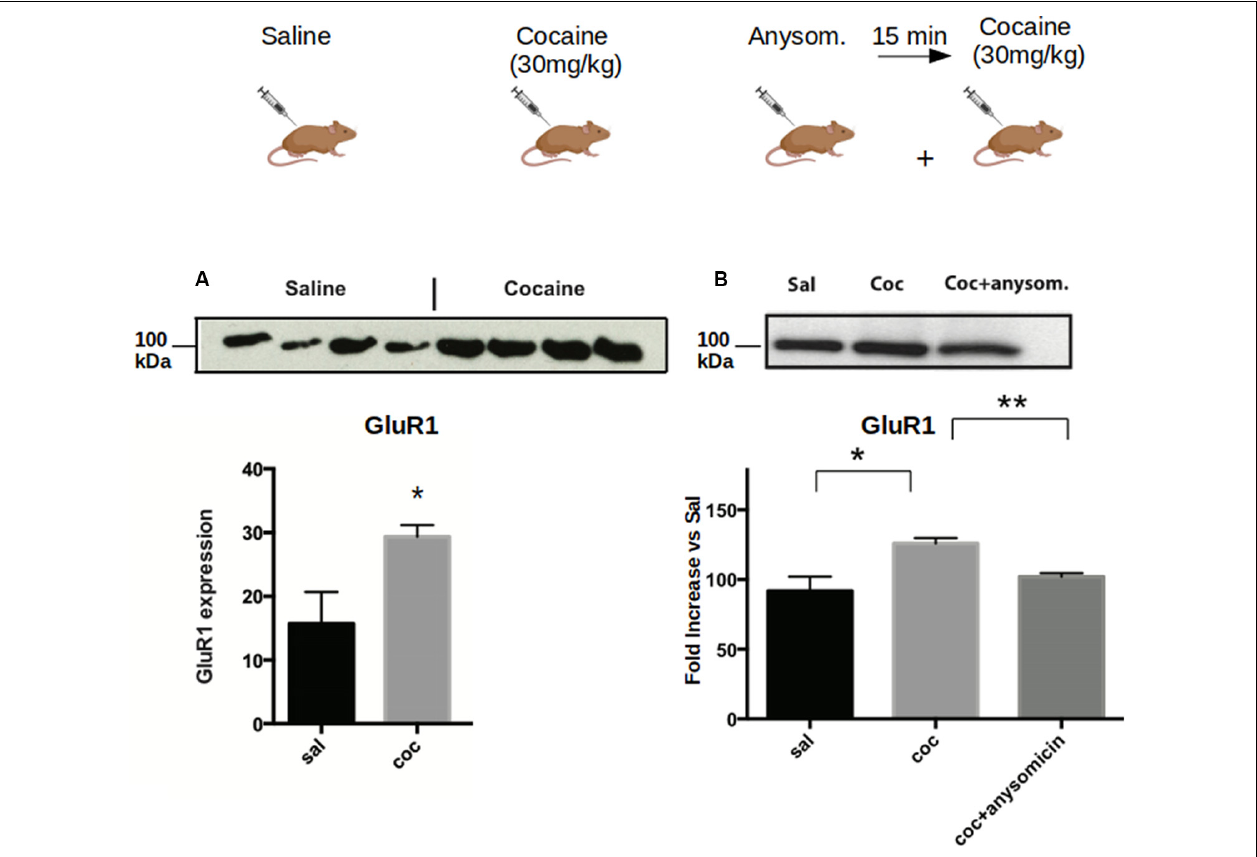
FIGURE 2 | Cocaine induces increased expression of CPEB1 and CPEB3 that is dependent on translation. Striata from mice ( n = 4) treated with acute cocaine injections were homogenized and used to analyze the expression of GLUR1, a shared target of CPEB1 and CPEB3. (A) GluR1 is upregulated following acute cocaine injection ( p = 0.0001, Student’s t -test. (B) . The increased expression of the protein is not observed when mice have been previously injected with the translation inhibitor anisomycin ( p = 0.86), suggesting that the cocaine-induced protein expression is translationally dependent. * p < 0.05, ** p <